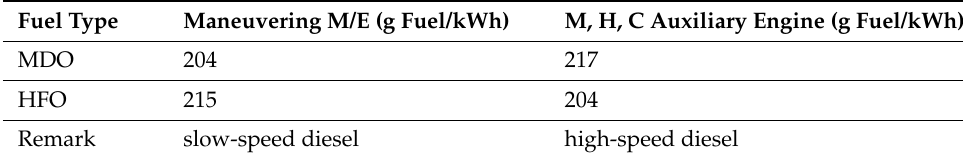
Table 4. Tier-3 specific fuel oil consumption